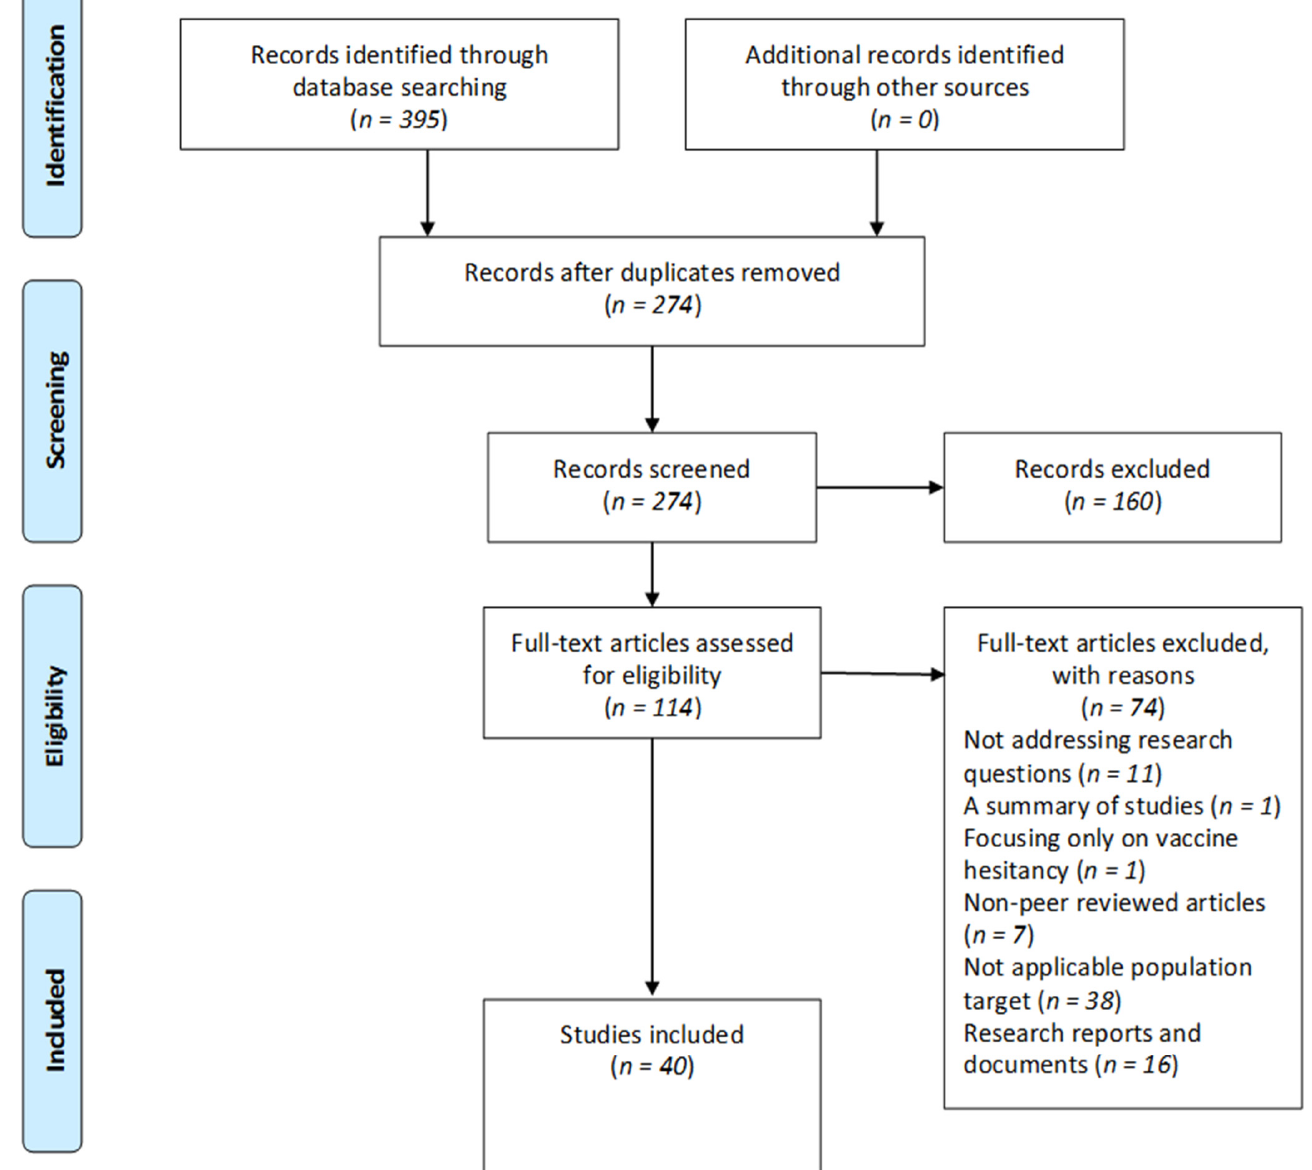
Figure 1. PRISMA flow diagram: selection of included